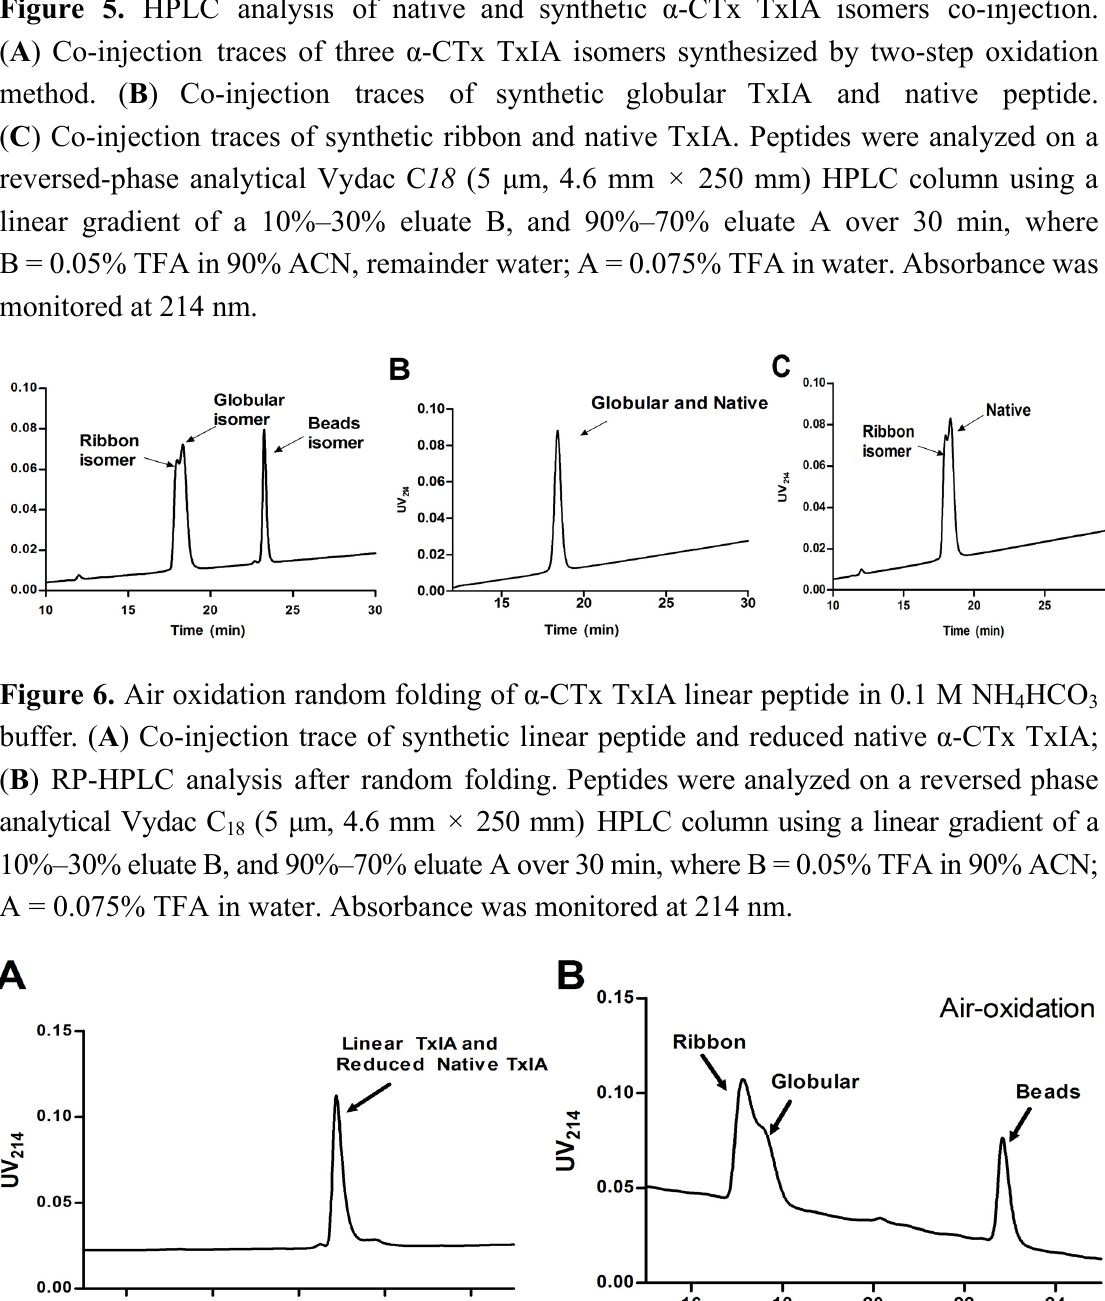
Figure 5. HPLC analysis of native and synthetic α -CTx TxIA isomers co-injection.